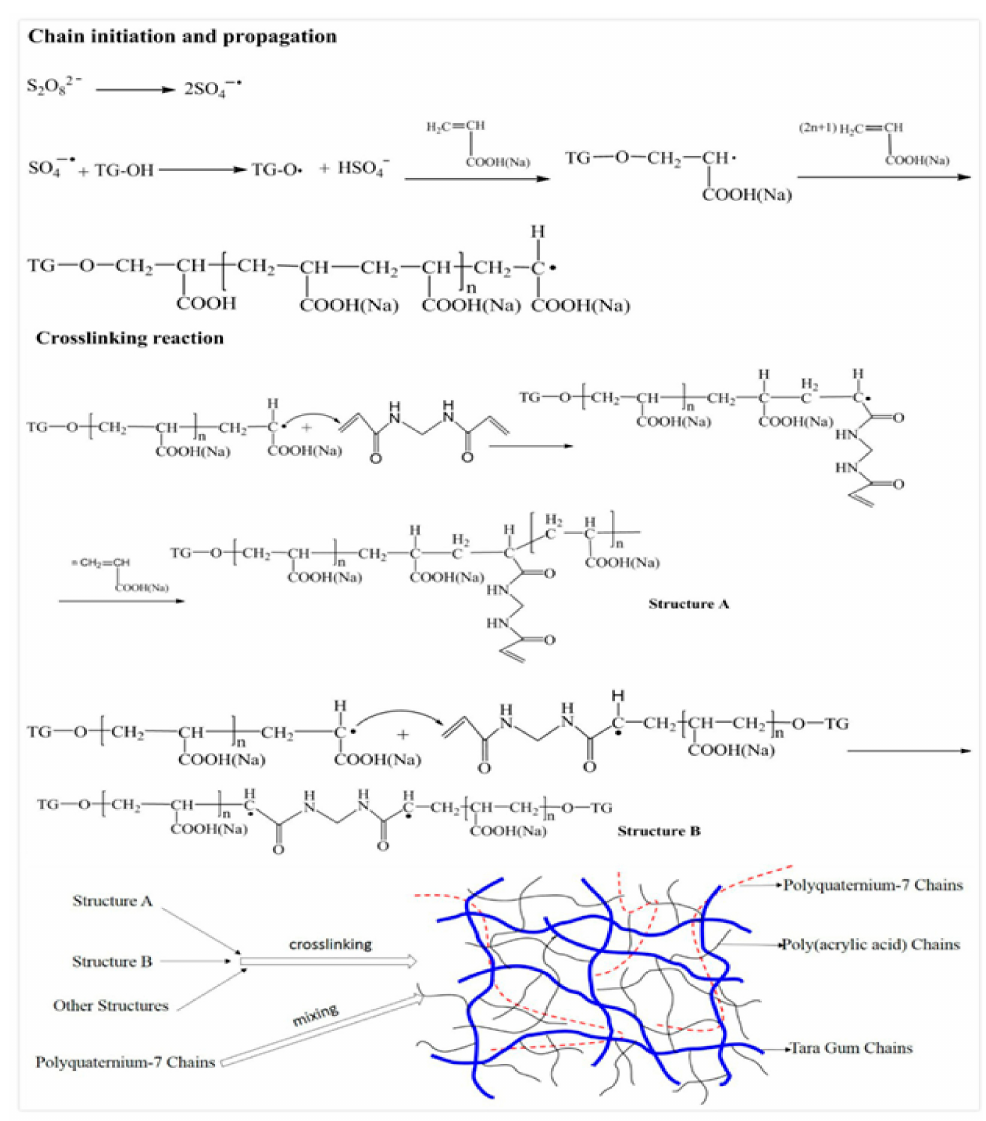
Figure 1. Synthesis mechanism of the antibacterial